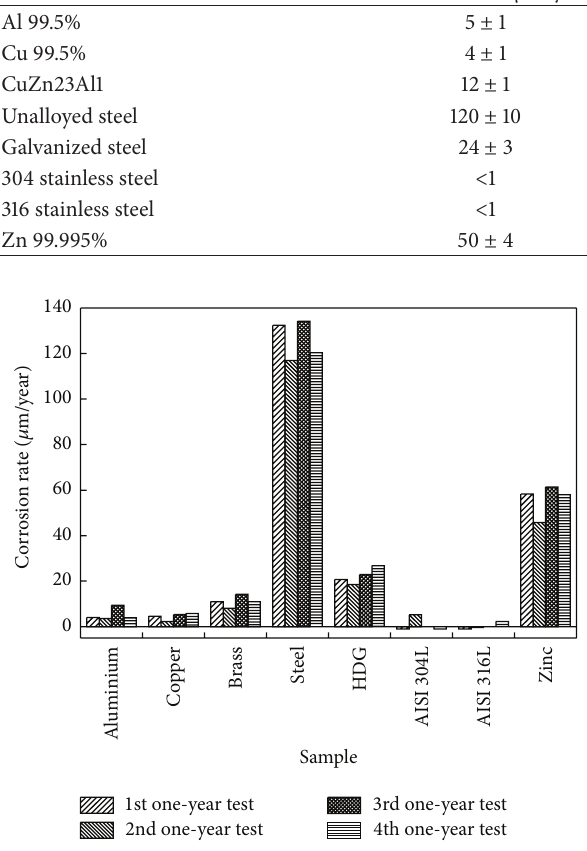
Figure 8: Variation of corrosion rates in immersion tests in succes- sive 1-year tests.